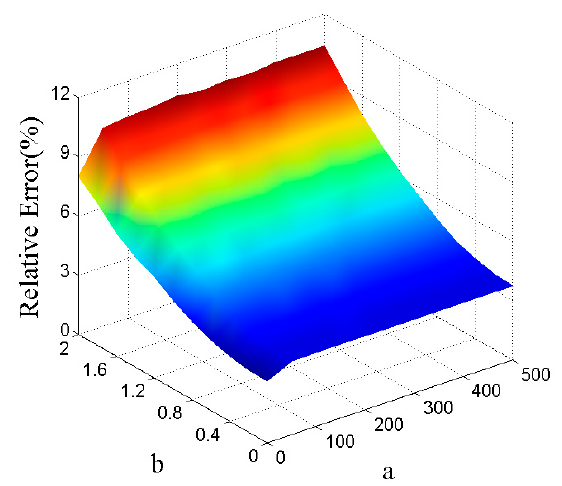
Figure 3. Relative errors for different a and b.